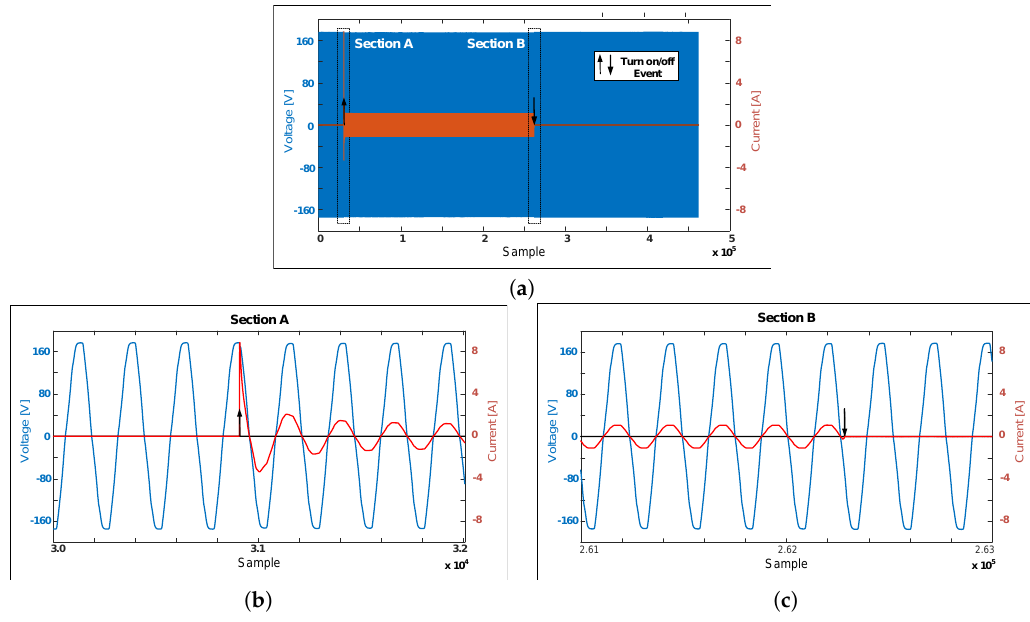
Figure 12. Jig acquisition of a single load: incandescent lamp—trigger angle of 90 degrees. ( a ) Complete acquisition—AC mains voltage and current. ( b ) Turn-ON event. ( c ) Turn-OFF